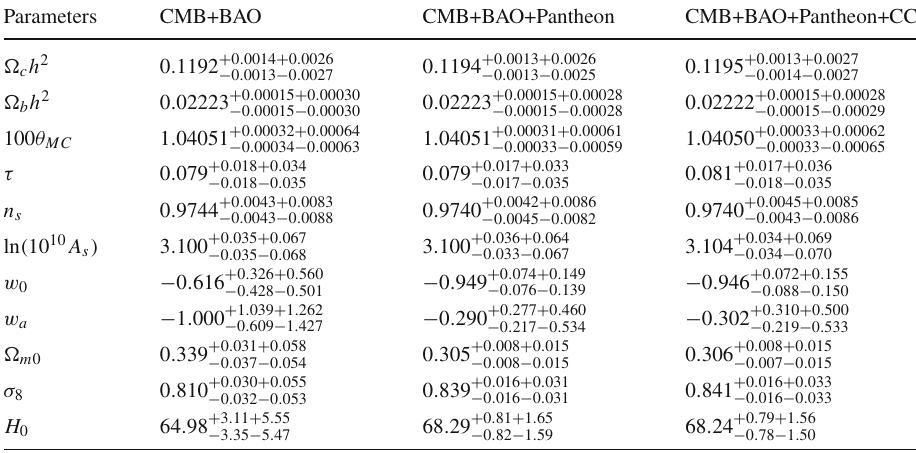
Fig. 7 68% and 95% CL contour plots for various combinations of the model parameters of Ext1 of (7) [the CPL parametrization] have been shown for different observational combinations. The figure also